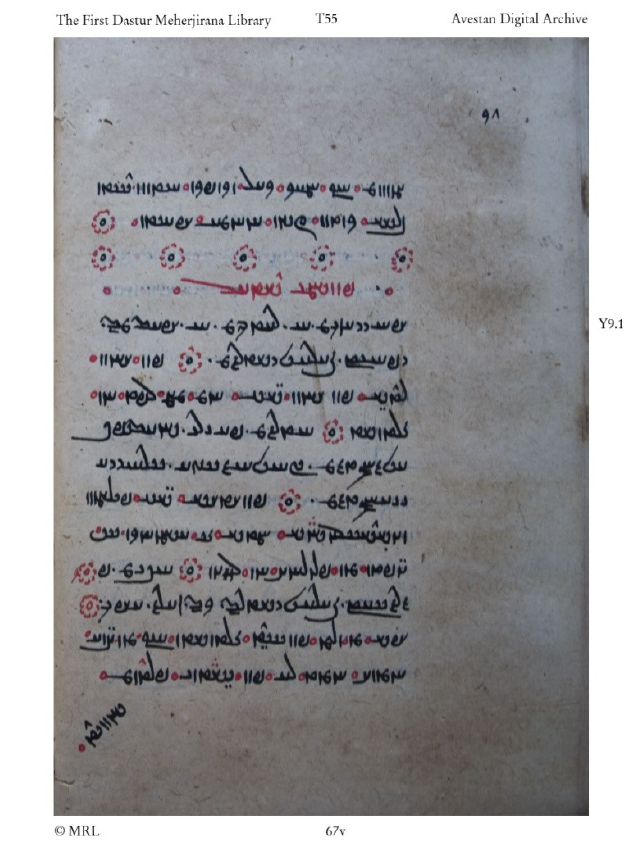
Figure 2 Fol. 57v from Yasna Pahlavi Hs T55 (Andrés-Toledo